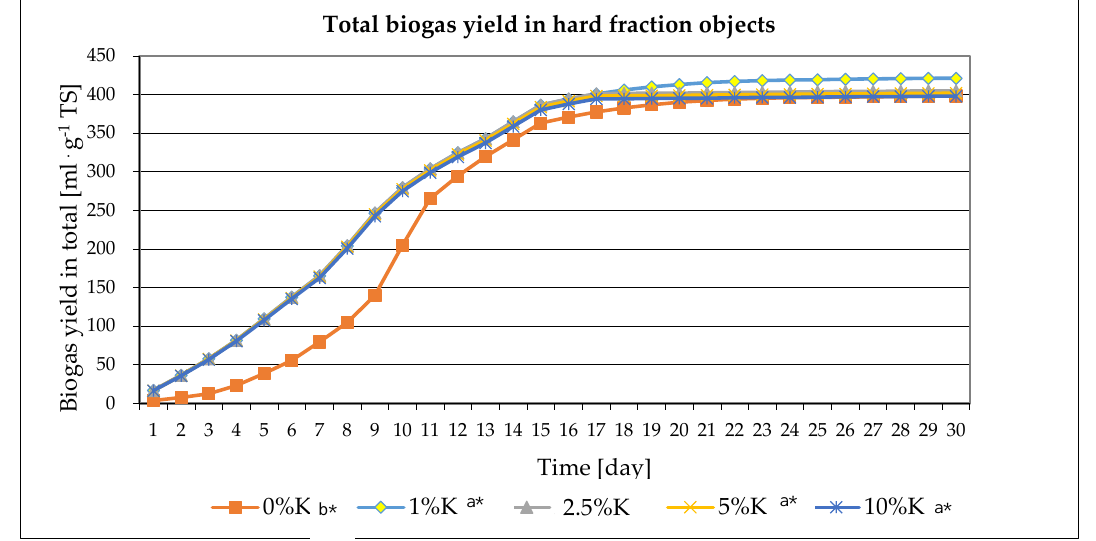
Figure 2. Total biogas yield in hard fraction objects. *Different letters mean statistically significant differences at the significance level p = 0.05.